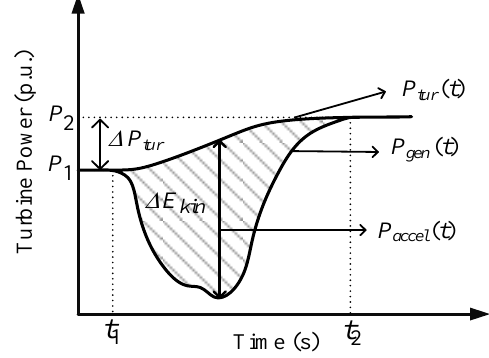
Figure 2. Variation in the wind turbine mechanical power as function of the accelerating energy and power.